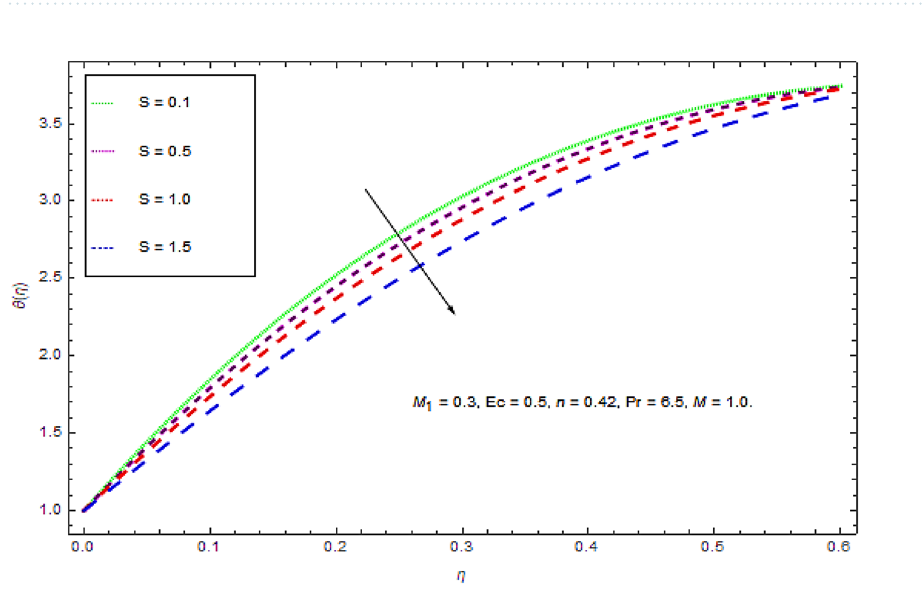
Figure 7. Impact of S on θ(η)